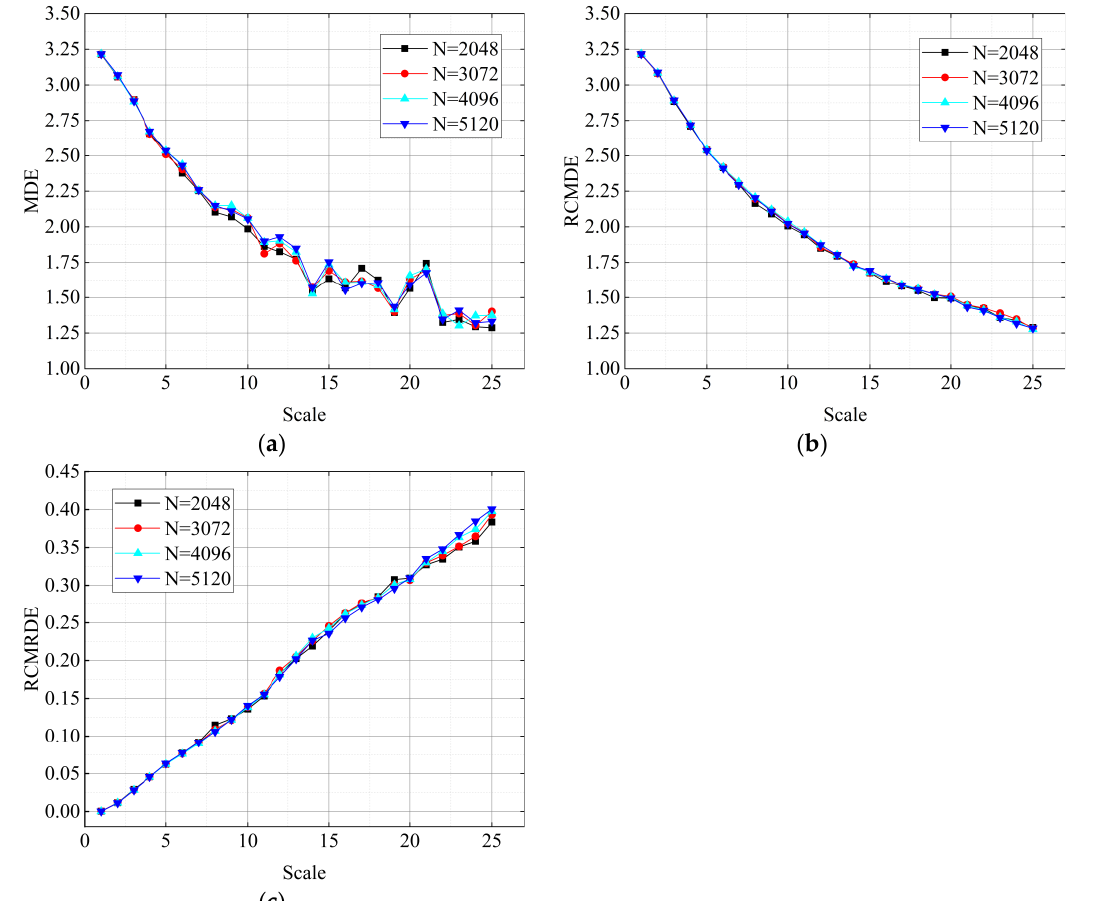
Figure 2. The MDE, RCMDE, and RCMRDE of WGN noise under different data lengths: ( a ) MDE; ( b ) RCMDE; ( c ) RCMRDE.